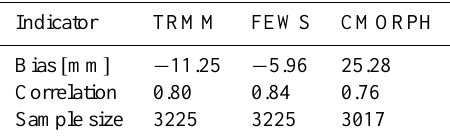
Table 4. Characteristics of the global satellite versus GPCC